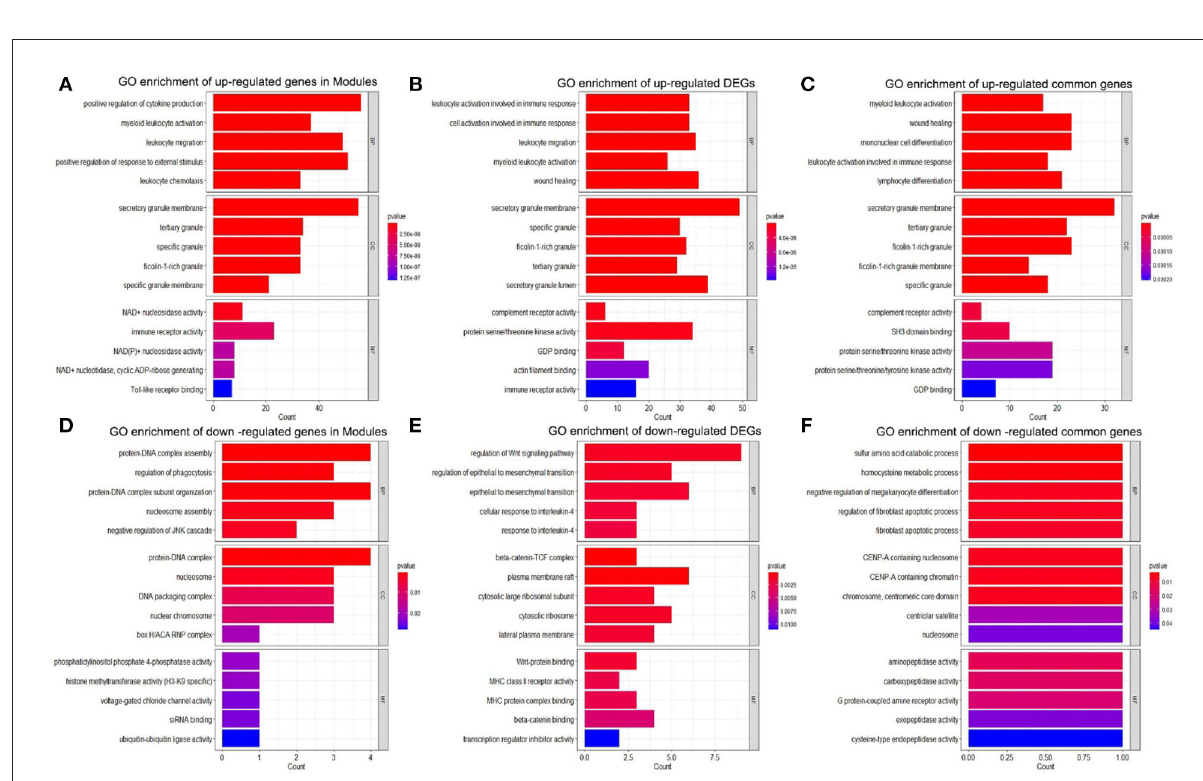
FIGURE5 GO enrichment analysis. (A) GO enrichment of upregulated genes in the modules. (B) GO enrichment of upregulated DEGs. (C) GO enrichment of upregulated common genes. (D) GO enrichment of downregulated genes in Modules. (E) GO enrichment of downregulated DEGs. (F) GO enrichment of downregulated common genes. DEGs, differentially expressed genes; GO, gene